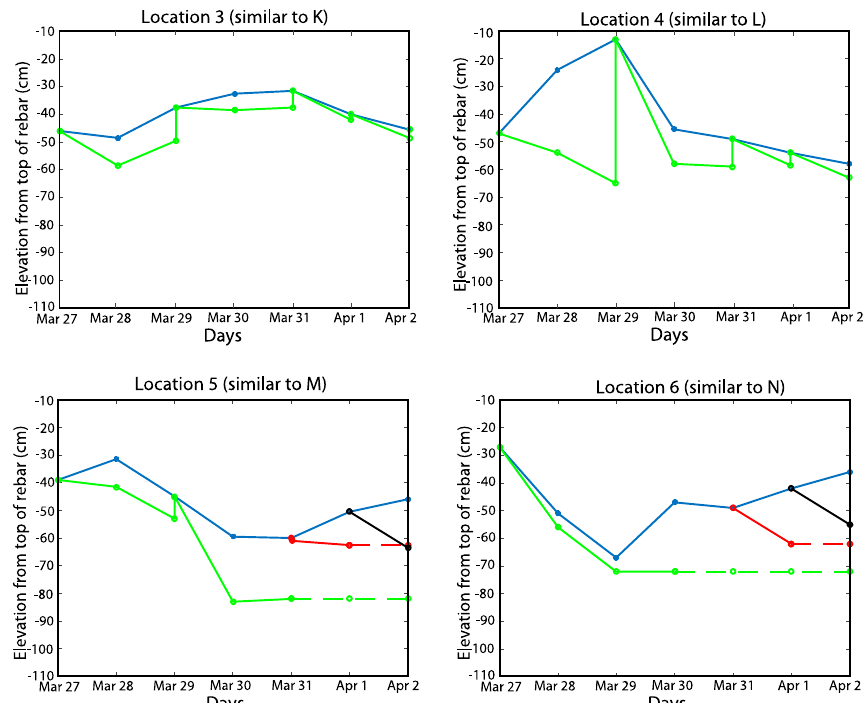
Figure 9. Depth of disturbance measurements from four different locations on the beach (the lowest four circles in Figure 1). The blue lines show the daily vertical position of the beach surface with respect to the top of the rebar. The green lines (and red and black) show the depth below the sand surface to which the washer was buried. Dashed lines represent times when the washer could no longer be found, and color changes ( i . e ., red and black) indicate when a new washer was placed on the same rebar. Vertical lines indicate when the washer was removed and replaced on the surface. It should be noted that the elevations are not relative to NAVD88 but instead are relative to the top of the